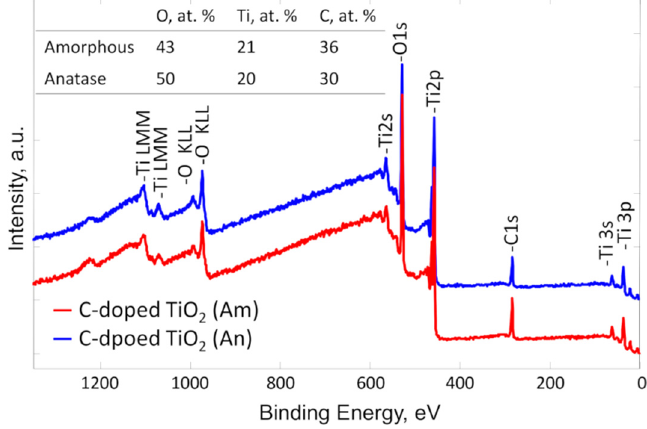
Figure 4. XPS survey spectra and elemental composition of C-doped TiO 2 amorphous (red line) and C-doped TiO 2 anatase (blue line).